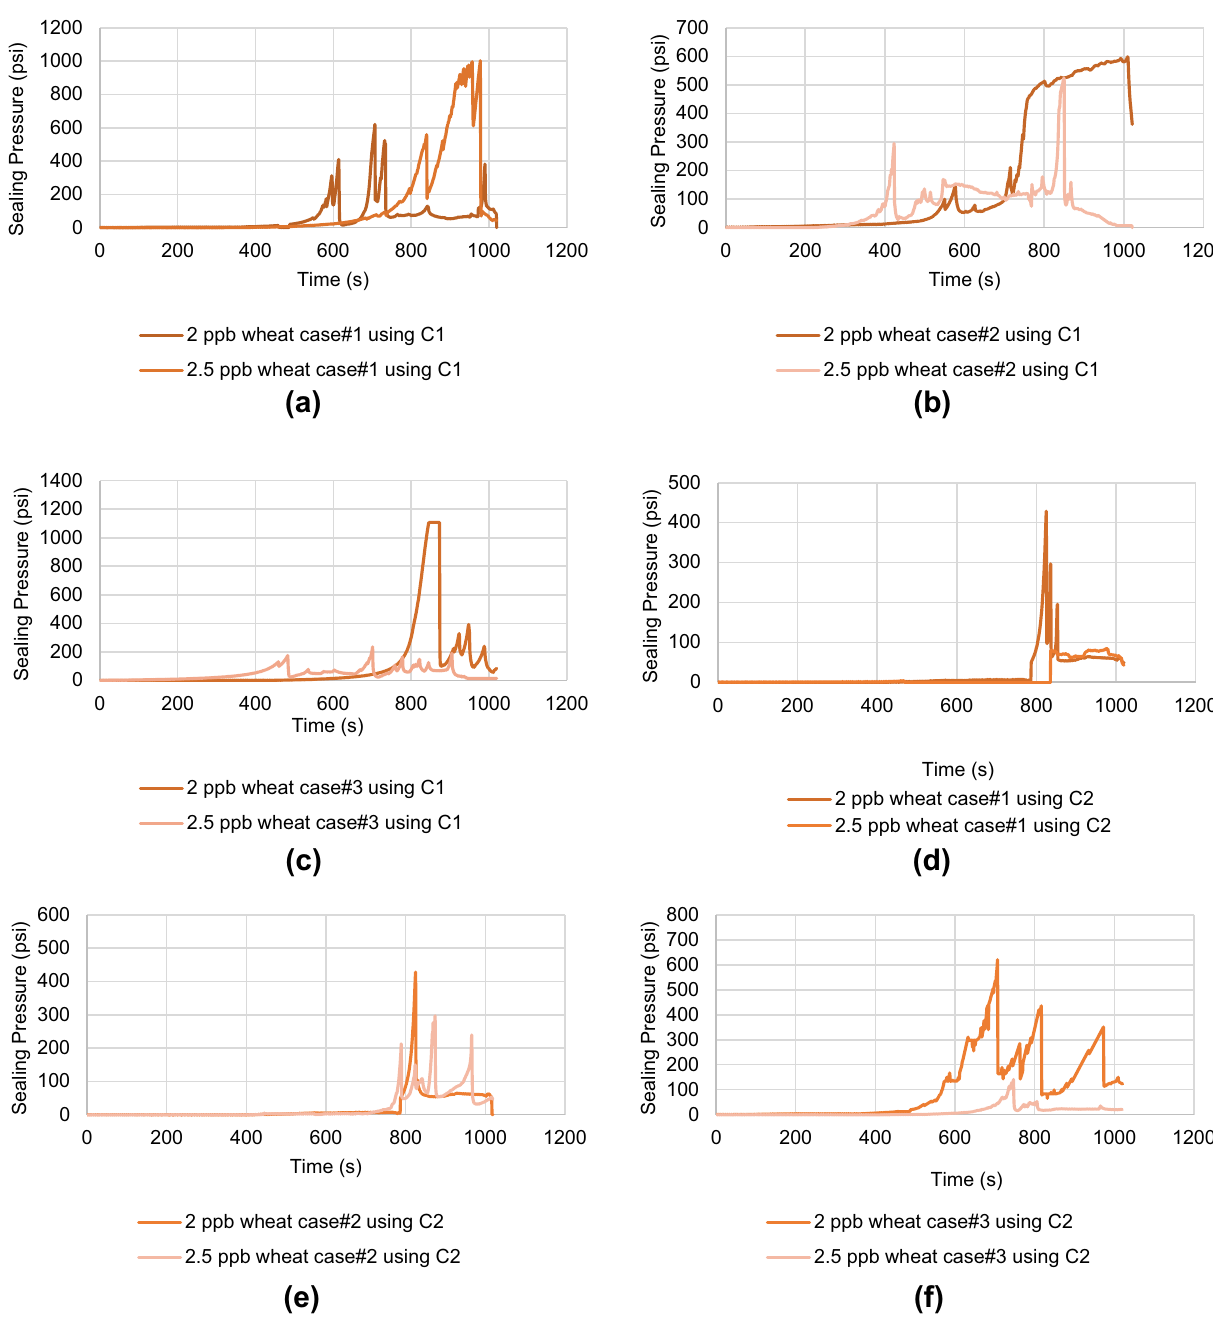
Fig. 21 HPA Pressure versus Time plot for Wheat Straw showing maximum sealing pressure at different concentrations, a case#1, b case#2, c case#3, d case#1, e case#2, f